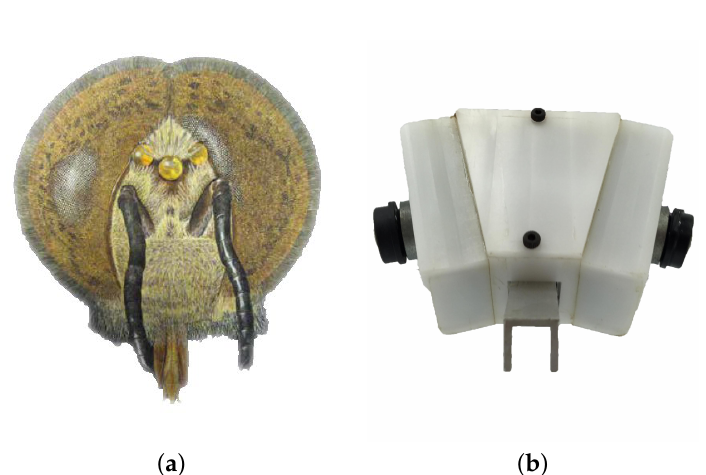
Figure 3. ( a ) Compound eyes of a honeybee—by Michael J. Roberts. Copyright the International Bee Research Association and the L. J. Goodman Insect Physiology Research Trust. Reproduced with permission from [51]; ( b ) Vision system on flight platform.